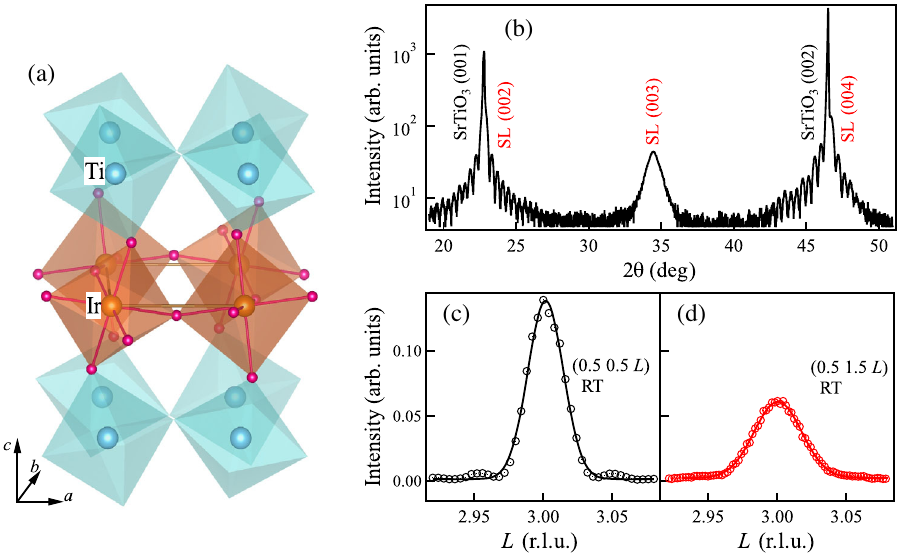
FIG. 1. Structure characterization. (a) Crystal structure of the ½ð SrIrO 3 Þ 1 = ð CaTiO 3 Þ 1 (cid:2) SL grown on a SrTiO 3 substrate. (b) X-ray θ - 2 θ scan pattern of the SL. (c),(d) Room-temperature (RT) synchrotron XRD measured around the (0.5 0.5 3) and (0.5 1.5 3)